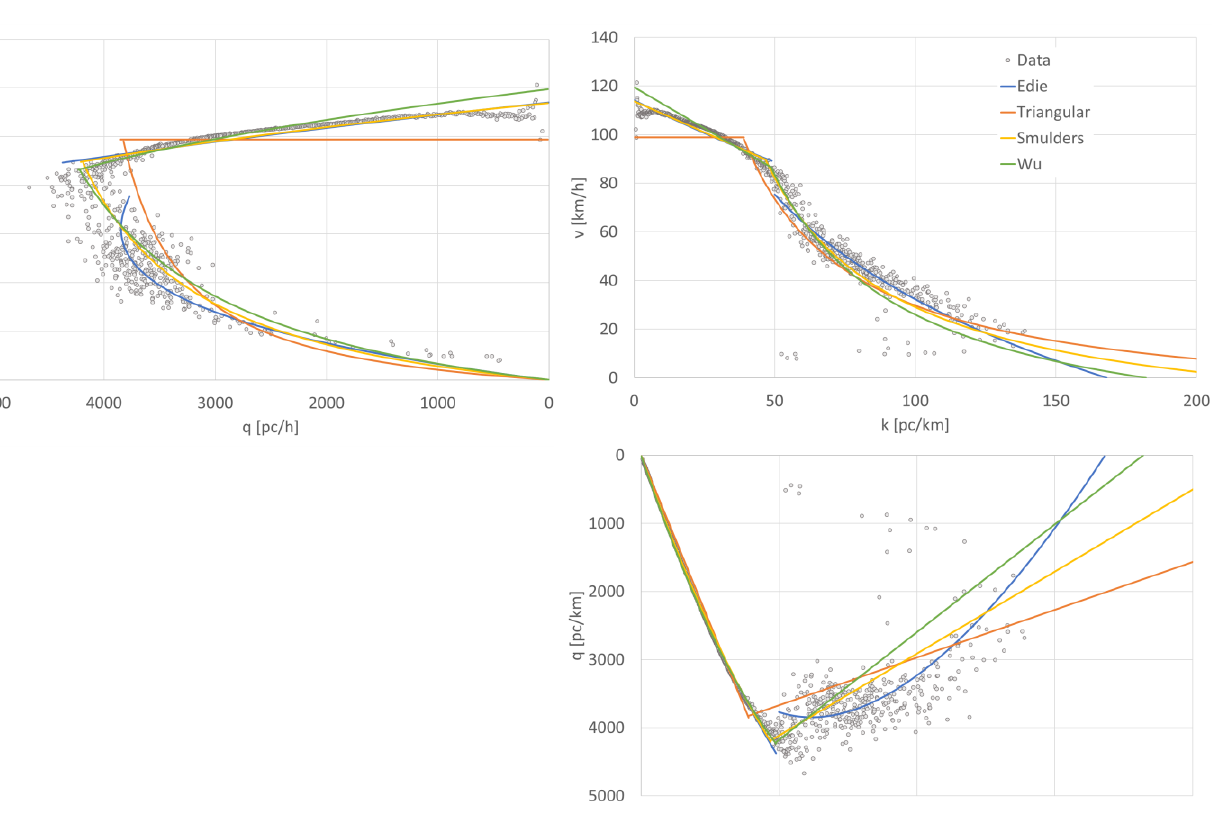
Figure 8. Fundamental diagram represented by two-regime models.